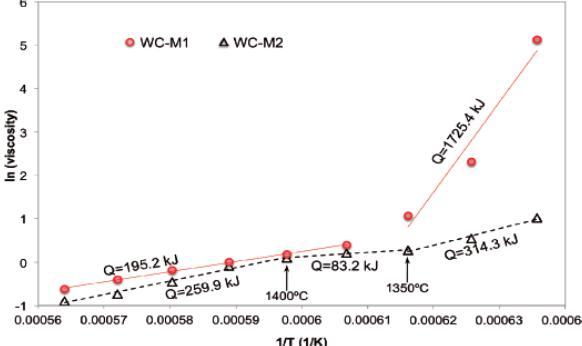
Fig. 3: Natural logarithm of viscosity vs. inverse of temperature for two of the measurements, where Q is the activation energy. The third measurement (WC-M3) was nearly identical to